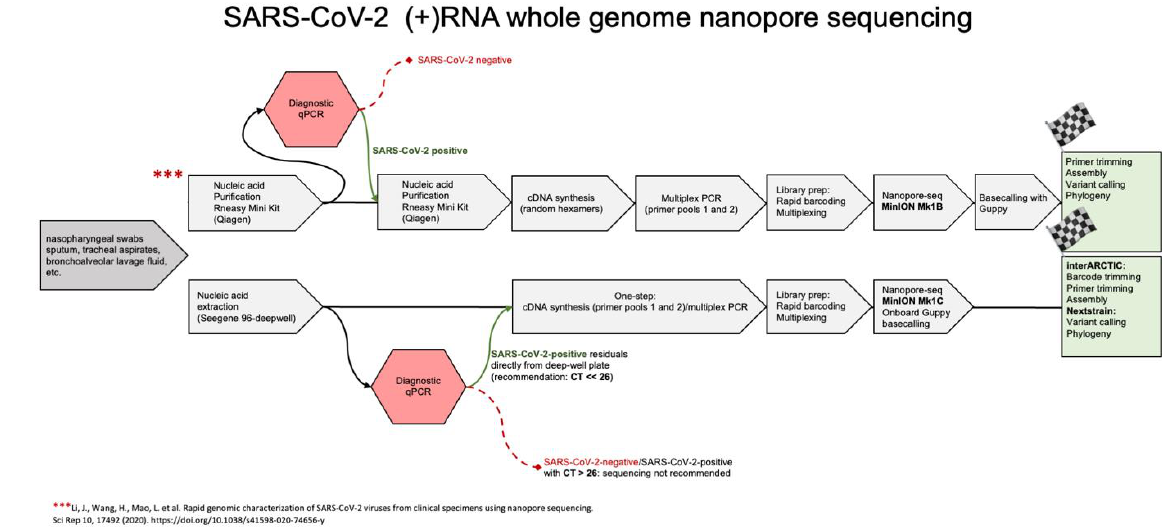
Figure 5. Comparison of a rapid SARS-CoV-2 whole (+)RNA genome nanopore sequencing pipeline [11] with the novel simplified workflow, whose main achievements are: 1. Purified RNA from SARS-CoV-2-positive patients can be directly taken from residual diagnostic specimens in 96-deepwell-plates; 2. cDNA synthesis and successive multiplex PCR with 2 primer pools can be performed in single tube reactions. Since cDNA synthesis is primed by SARS-CoV-2-specific primers for 1200 bp amplicon amplification, there is no need for use of unspecific hexanucleotide priming; 3. Onboard Guppy basecalling with the Oxford Nanopore MinION Mk1C device and implementation of the interARTIC led to a further reduction of working steps and hands-on time.